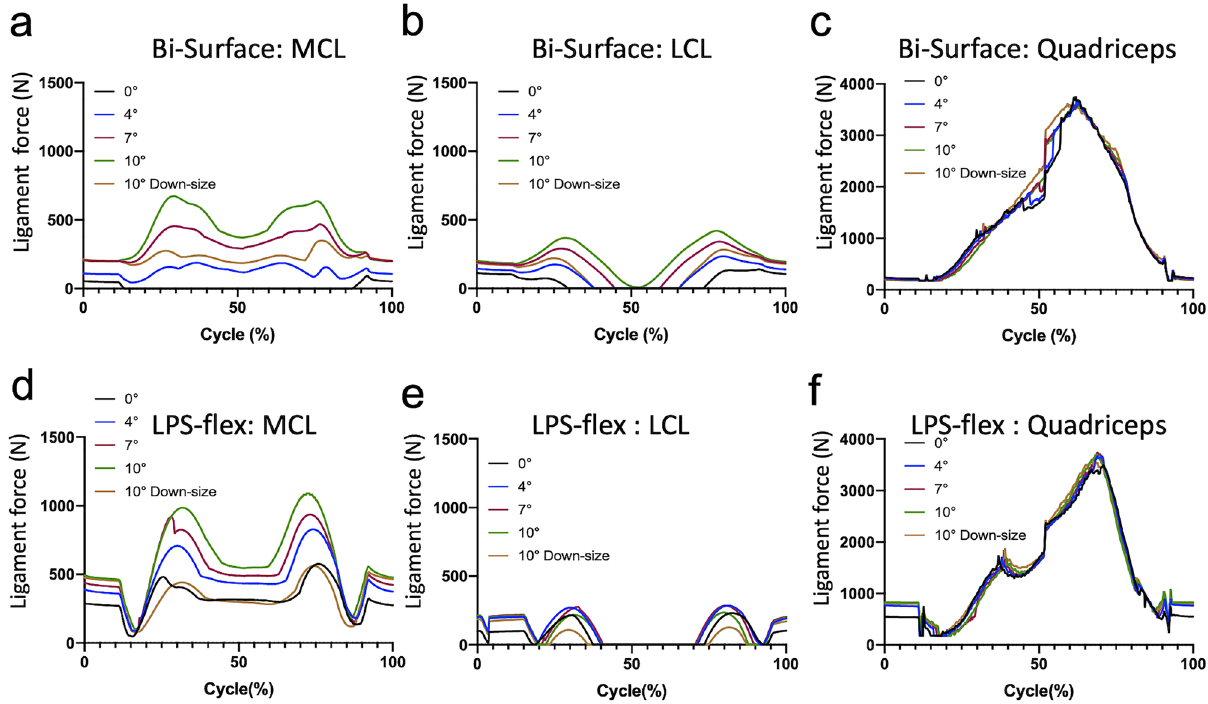
Figure 4. Ligament force in the Bi-Surface Knee ( a – c ) and LPS-flex ( d – f ). ( a , d ) medial collateral ligament, ( b , e ) lateral collateral ligament ( c , f ) quadriceps. MCL medial collateral ligament, LCL lateral collateral ligament.